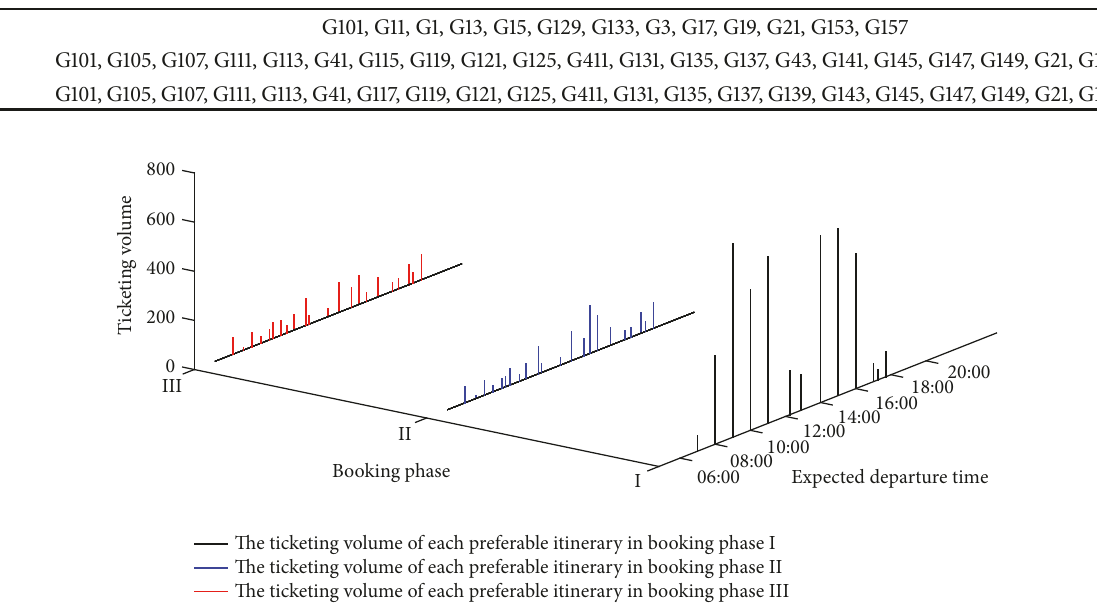
Figure 12: The ticketing volume of each itinerary in each booking phase from the MBPRA